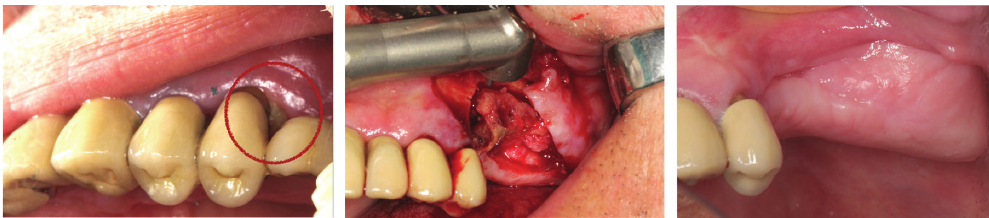
Figure 3: Left maxillar BRONJ stage I in a patient treated with zoledronic acid for brest cancer.